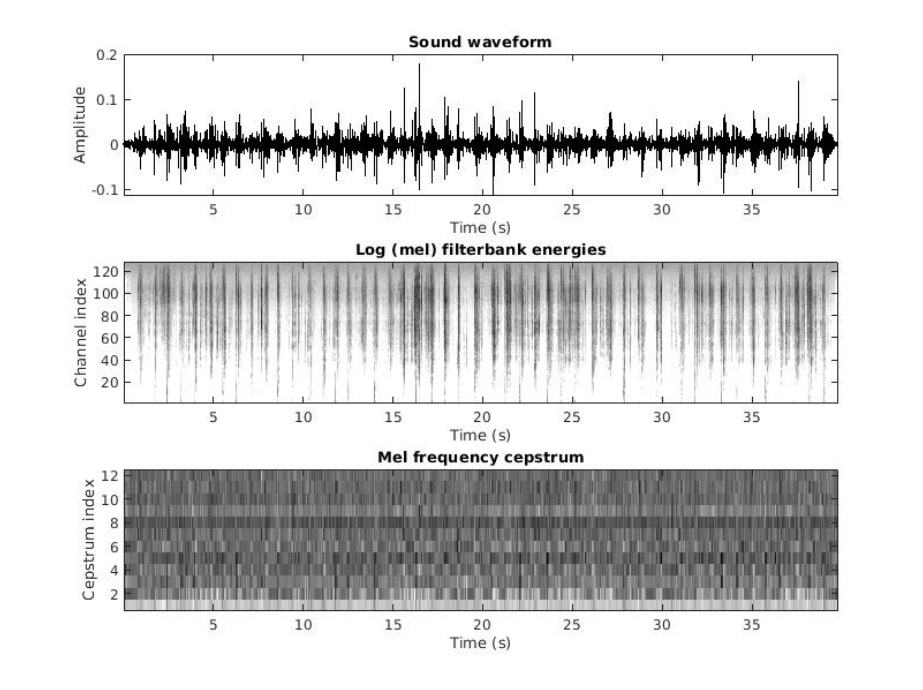
Figure 7. The sound waveforms, the logarithm of the filterbank energies, and the mel-frequency cepstrum graphic representation for the sound of the